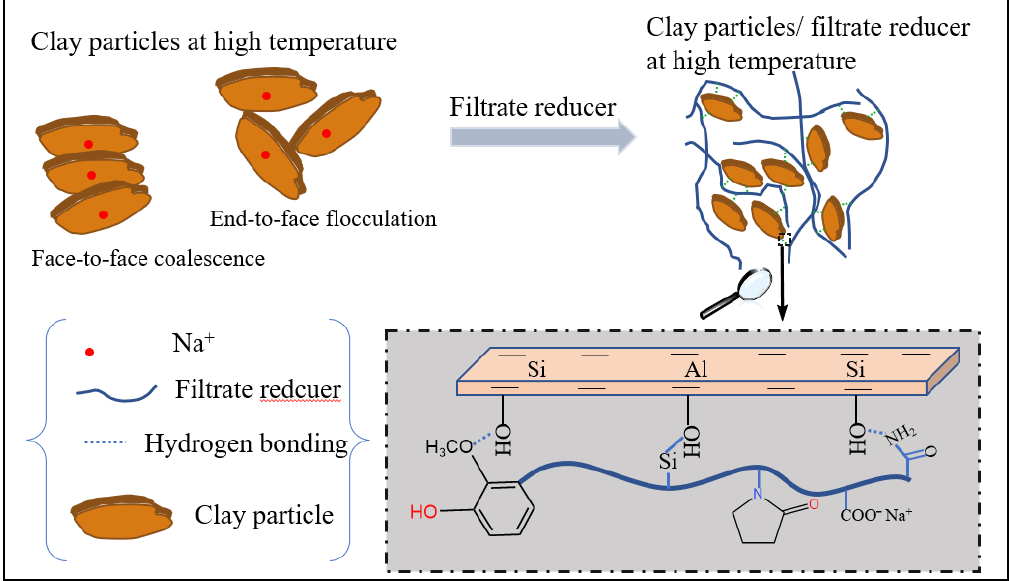
Figure 6. Analysis of the filtration control mechanism of